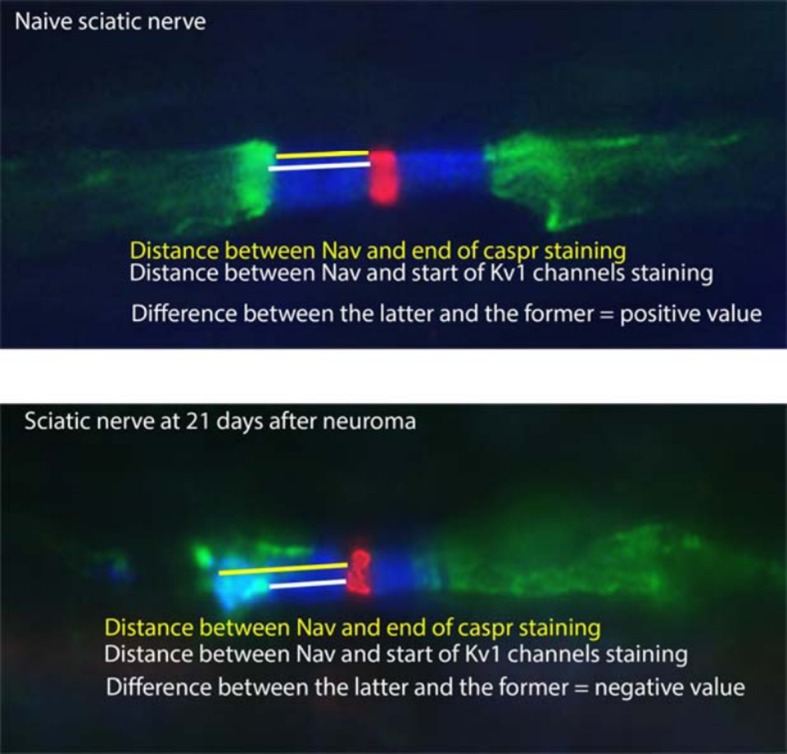
DOI:
http://dx.doi.org/10.7554/eLife.12661.026